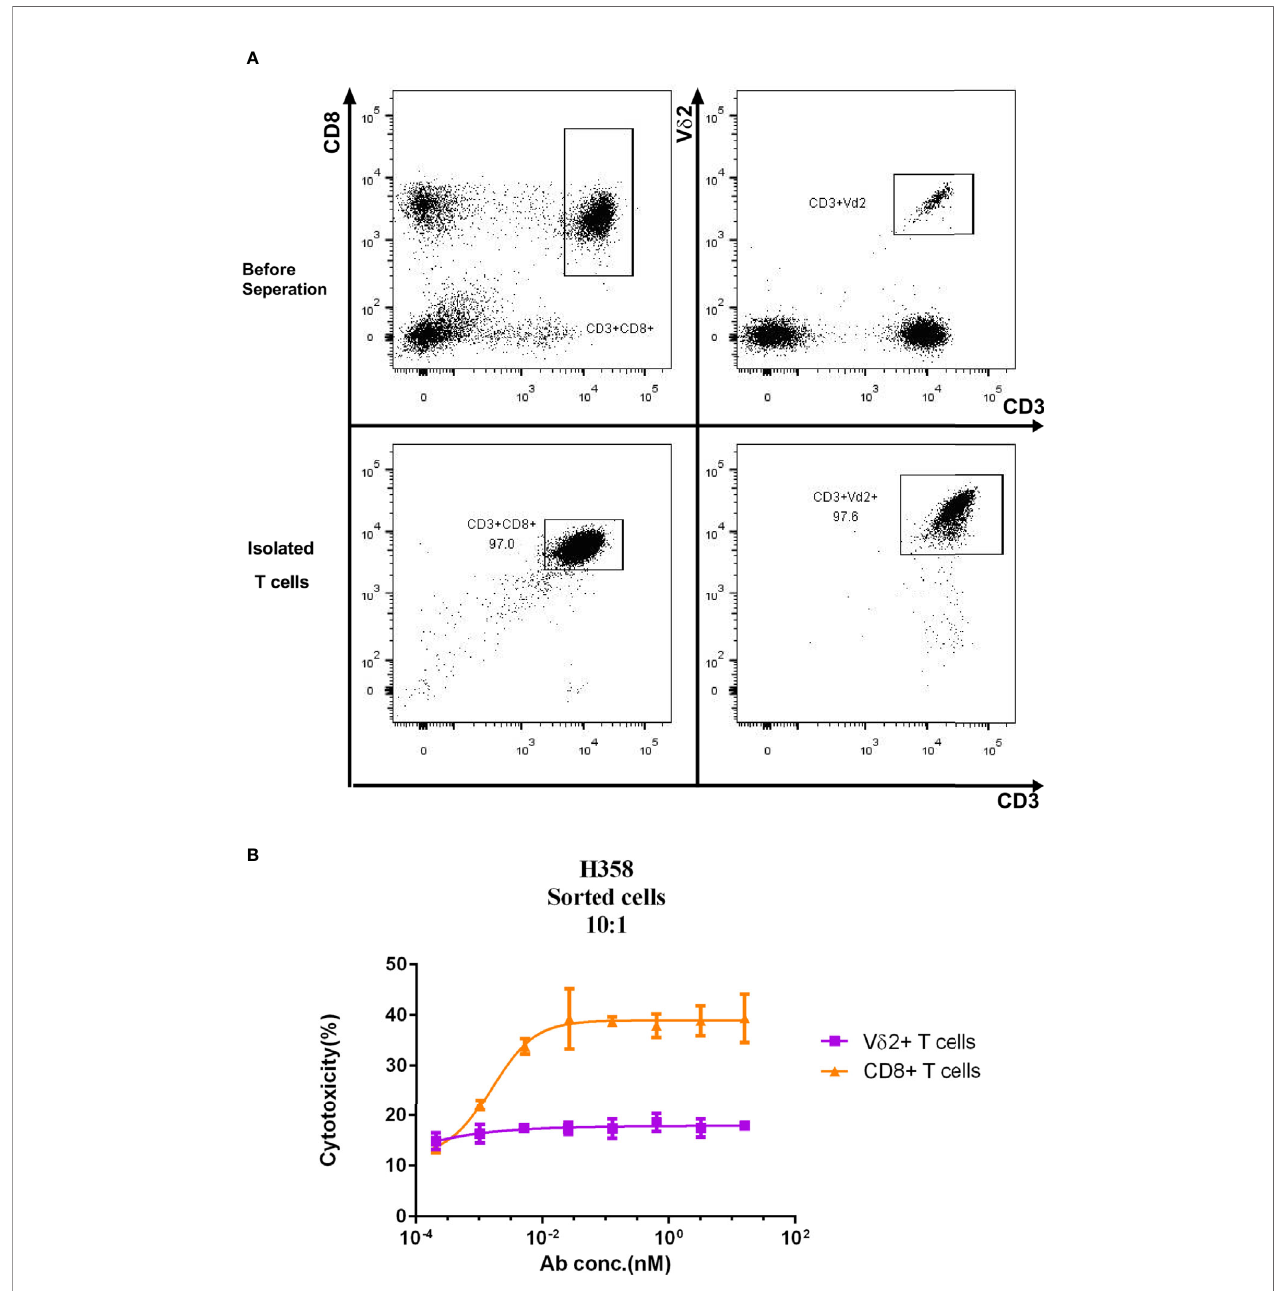
FIGURE 3 | Differential cytotoxicity of fresh CD8+ and V d 2+ T cells induced by Y111. (A) Representative plots show the purity of CD8+, and V d 2+ T cells enriched from PBMC by negatively magnetic beads separation. (B) The puri fi ed T-cell subsets from PBMC were co-cultured with CFSE-stained H358 in the presence of serial dilutions of the Y111 for the indicated time, then the proportions of killed target cells (PI+CFSE+) were plotted along with antibody concentration. The dots shown were from 3 independent experiments with T cells obtained from 5 healthy subjects. Data were analyzed using the “ log (agonist) vs. response (three parameters) ” method through an ordinary fi